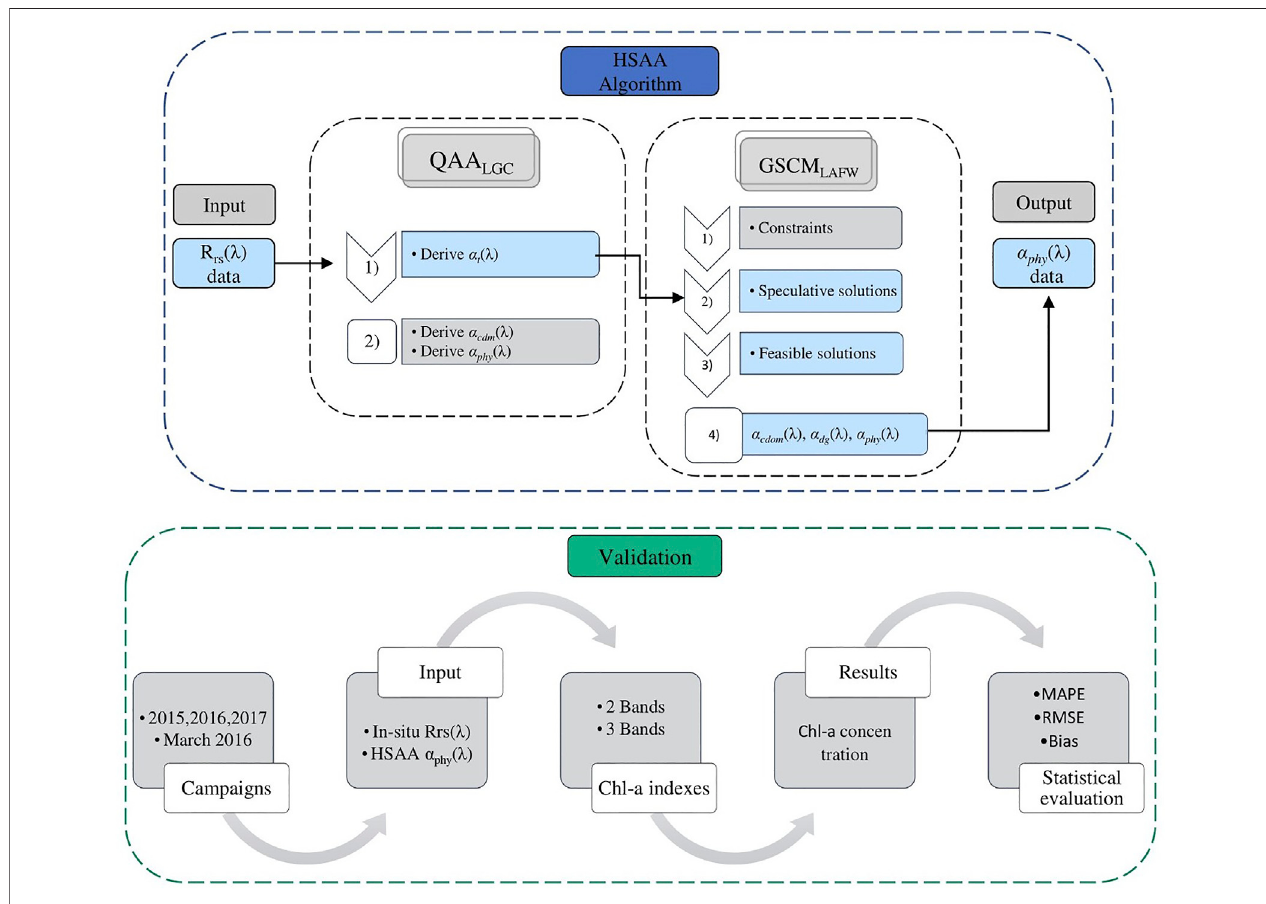
FIGURE 1 | Flowchart of the hybrid semi-analytical approach developed in this study (light blue). The Ch-a retrieval and validation steps are presented in green.